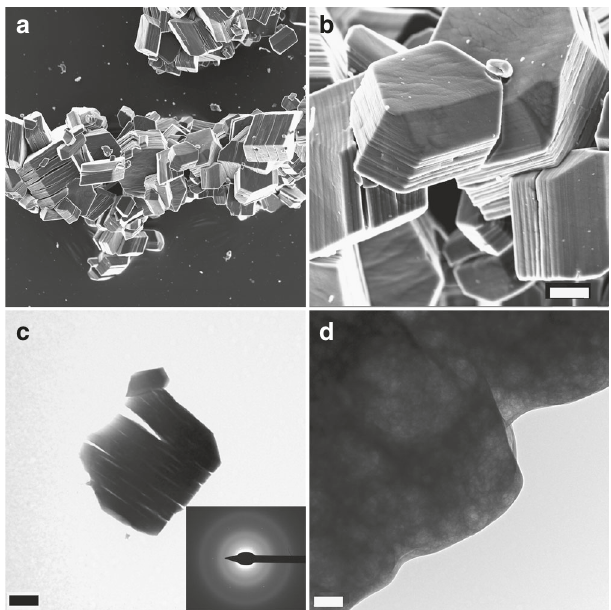
Fig. 9 Characterization of calcium oxalate precipitates formed in the presence of citrate (II). FESEM ( a , b ) and TEM ( c , d ) images of calcium oxalate particles (mostly caoxite, according to our XRD analysis — see Supplementary Fig. 5) obtained after the titration experiments (10 mM citrate pH 6.2). The SAED pattern of the crystals (shown as insets in c ) suggests that decomposition of the beam-sensitive oxalate material results in amorphization (see detail of the texture in d ). Scale bars : a – c 1 μ m. d 100